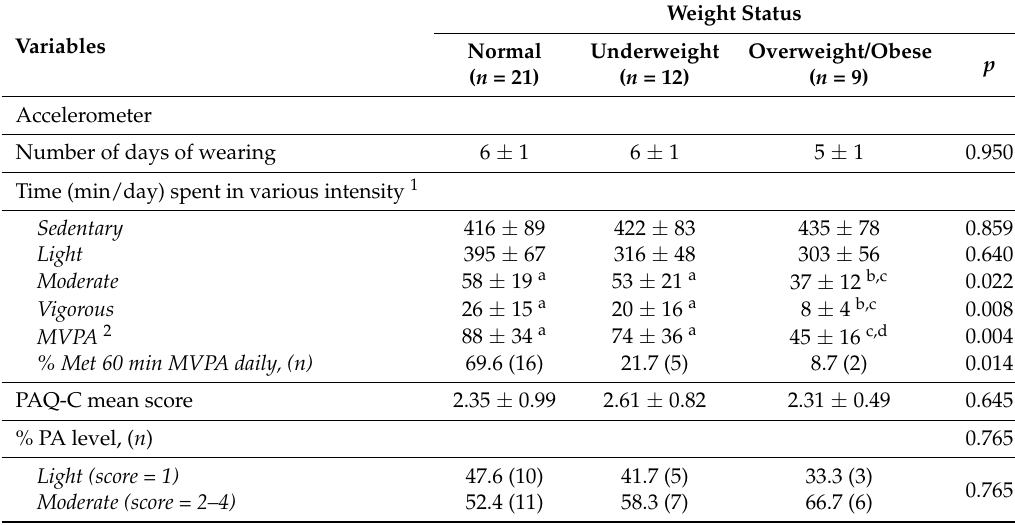
Table 3. Physical activity and sedentary behaviors by weight